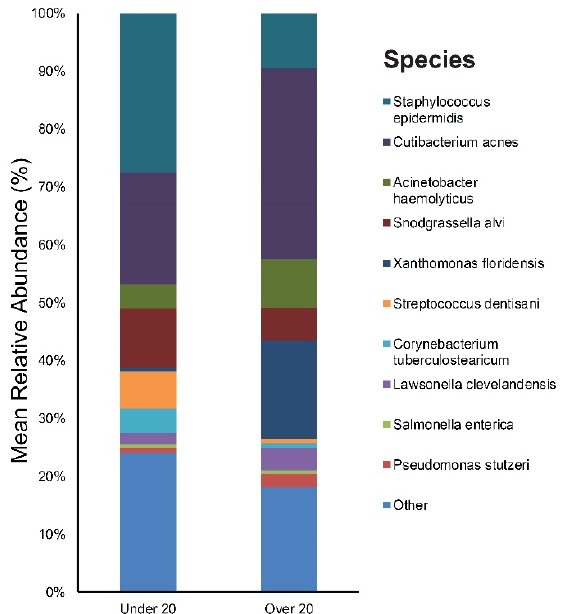
Figure 4. Bar graph on baseline skin microbiota in acne patients according to age (under 20 and over 20).